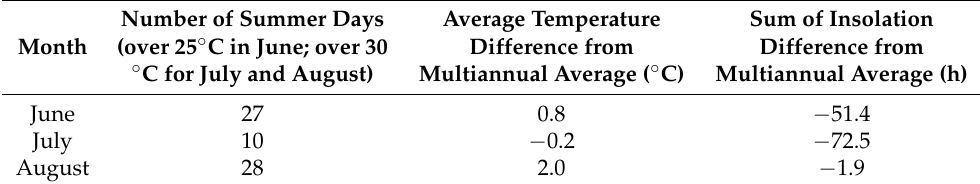
Table 1. Climatic conditions characterizing production season in which investigations were conducted. Sum of Insolation Average Temperature Number of Summer Days Difference from Difference from Month (over 25 ◦ C in June; over 30 ◦ C for July and August) Multiannual Average (h) Multiannual Average ( ◦ C) June 27 0.8 July August 28 Source: Republic Hydrometeorological Service of Serbia (http://www.hidmet.gov.rs/, accesed on 15 February 2021). The smallest reduction wasrecorded withpearl, then withred nets, and the largest PAR reduction is recorded withblue nets. The reduction of PAR also depended on the period during the day. Thus, a greater reduction in PAR was observed in the late afternoon compared to the morning ornoon. Temperature and relative humidity are less exposed to changes under the nets compared to light parameters (Table 2). Table 2. Influence of shading net on growing environment (average day in July). PAR a Temperature Relative Humidity Time Non- Non-Shaded (h) µ mol m − 2 Shaded